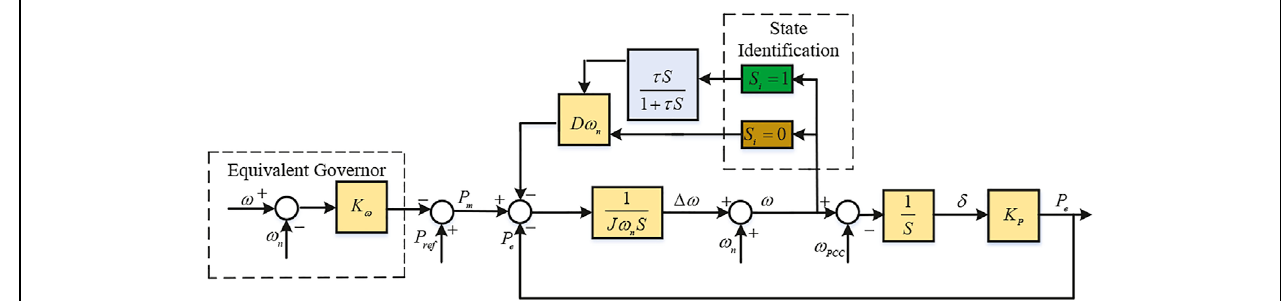
FIGURE 9 | Active power proportional distribution control strategy.